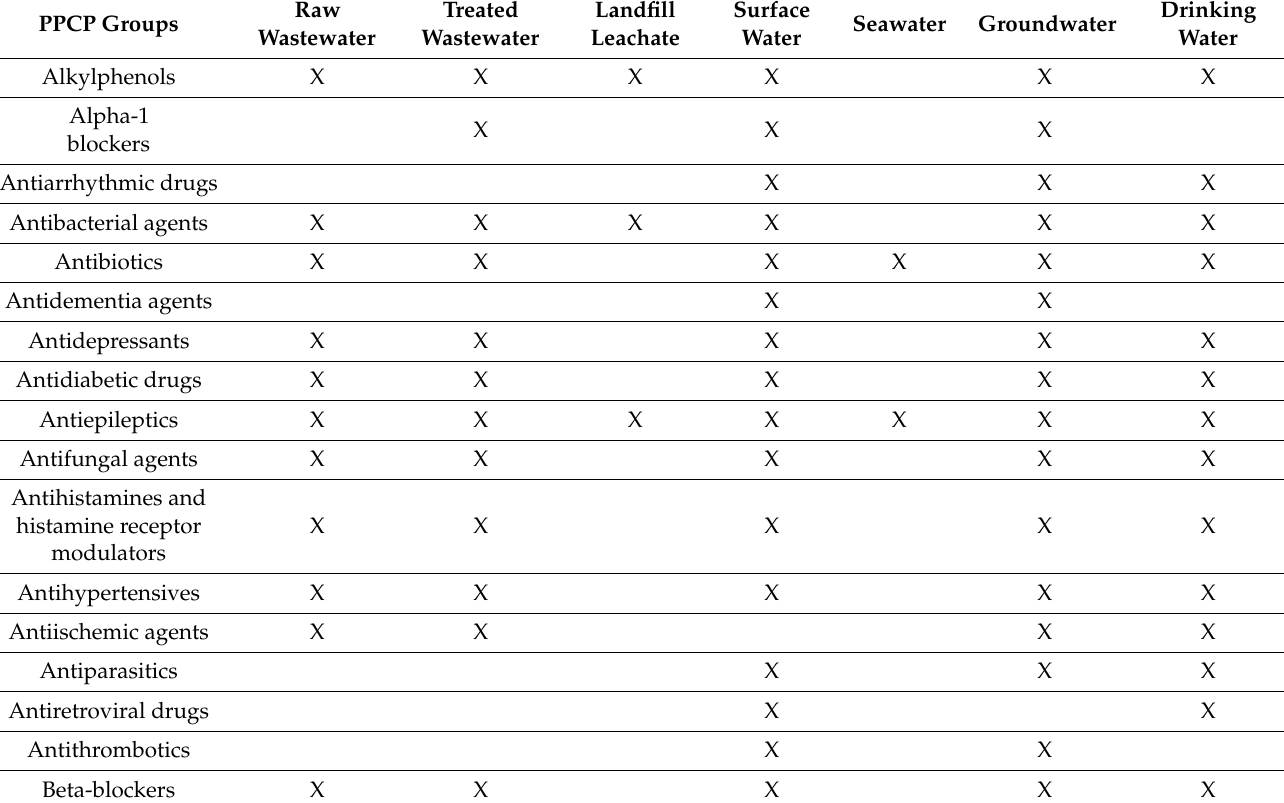
Table 2. PPCP groups studied in considered types of water samples in the review (marked as X). PPCP Groups